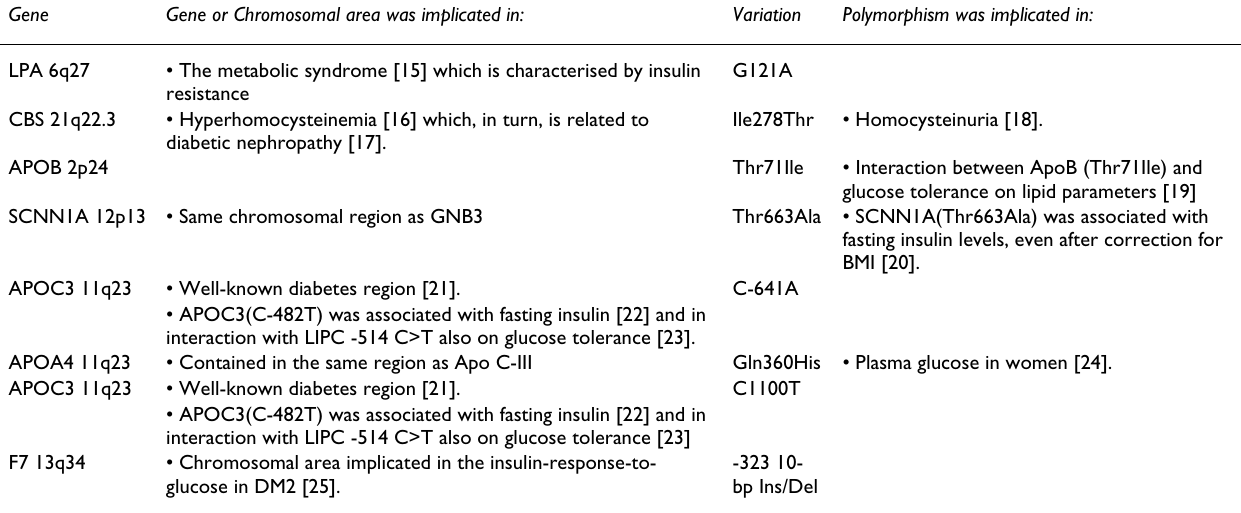
Table 7: Known effects of the genes and polymorphisms involved in susceptibility for disturbed glucose metabolism (i.e. subjects who were IGM or who had T2DM, with the false discovery rate of 0.125), with focus on parameters that are directly related to an insulin resistance and T2DM. Gene Gene or Chromosomal area was implicated in: Variation Polymorphism was implicated in: